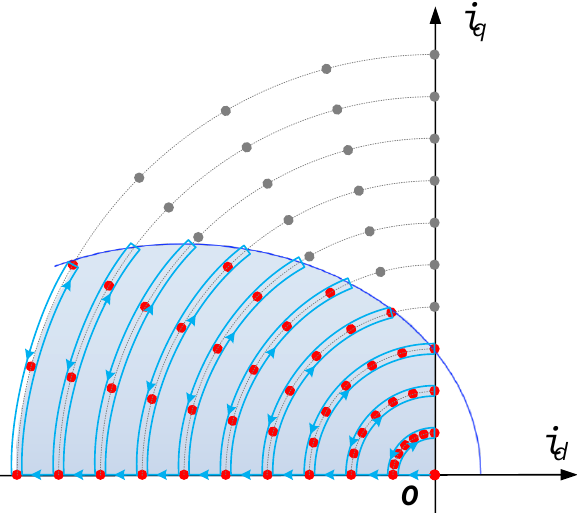
Figure 16. Current trajectory in the model building stage.